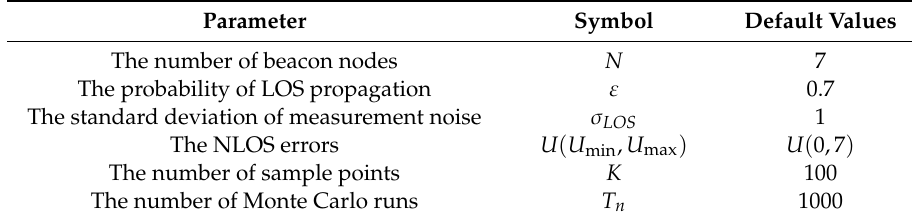
Table 3. The default parameters of a uniform